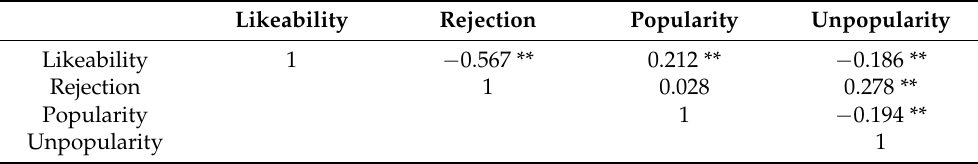
Table 2. Bivariate correlations peer status, spearman.